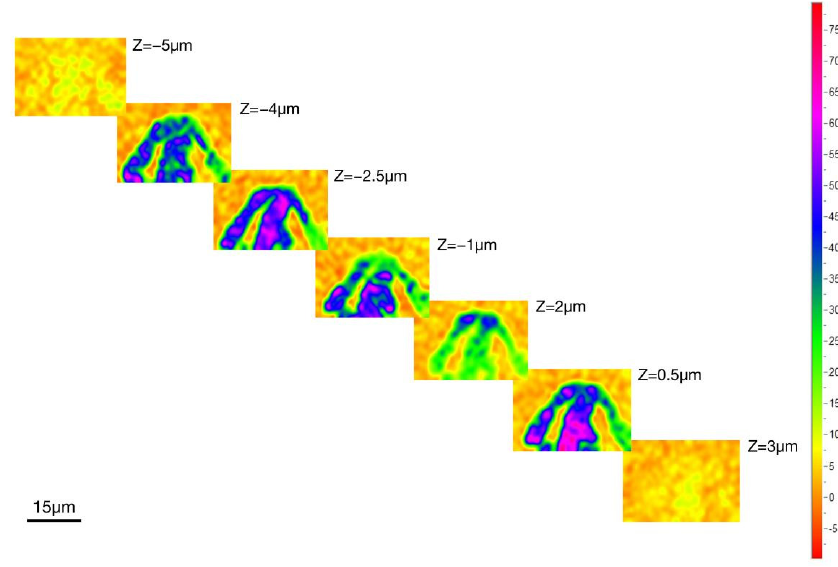
Figure 10. The 3D Raman mapping images show the variation in the strength of the 661 cm − 1 peaks, outlining the magnetite’s shape.